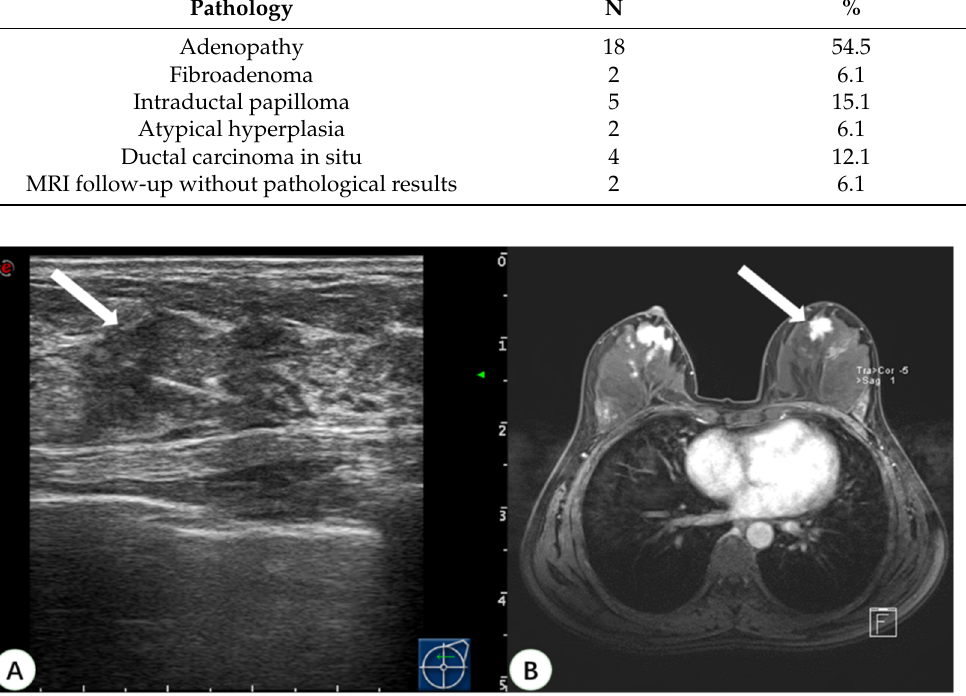
Figure 4. A 46-year-old woman with dense breast tissue underwent virtual navigation: ( A ) Real-time US with virtual navigation detected the corresponding lesion (arrow) in the left breast at the 12-o’clock position 2 cm from the nipple, which underwent ultrasound-guided biopsy; ( B ) CE-MRI showed a suspicious enhanced irregular lesion (arrow) in the upper left breast, undetected at second-look US. Pathology obtained by US-guided biopsy with virtual navigation demonstrated a ductal carcinoma in situ. US = ultrasound; CE-MRI = contrast-enhanced magnetic resonance imaging.